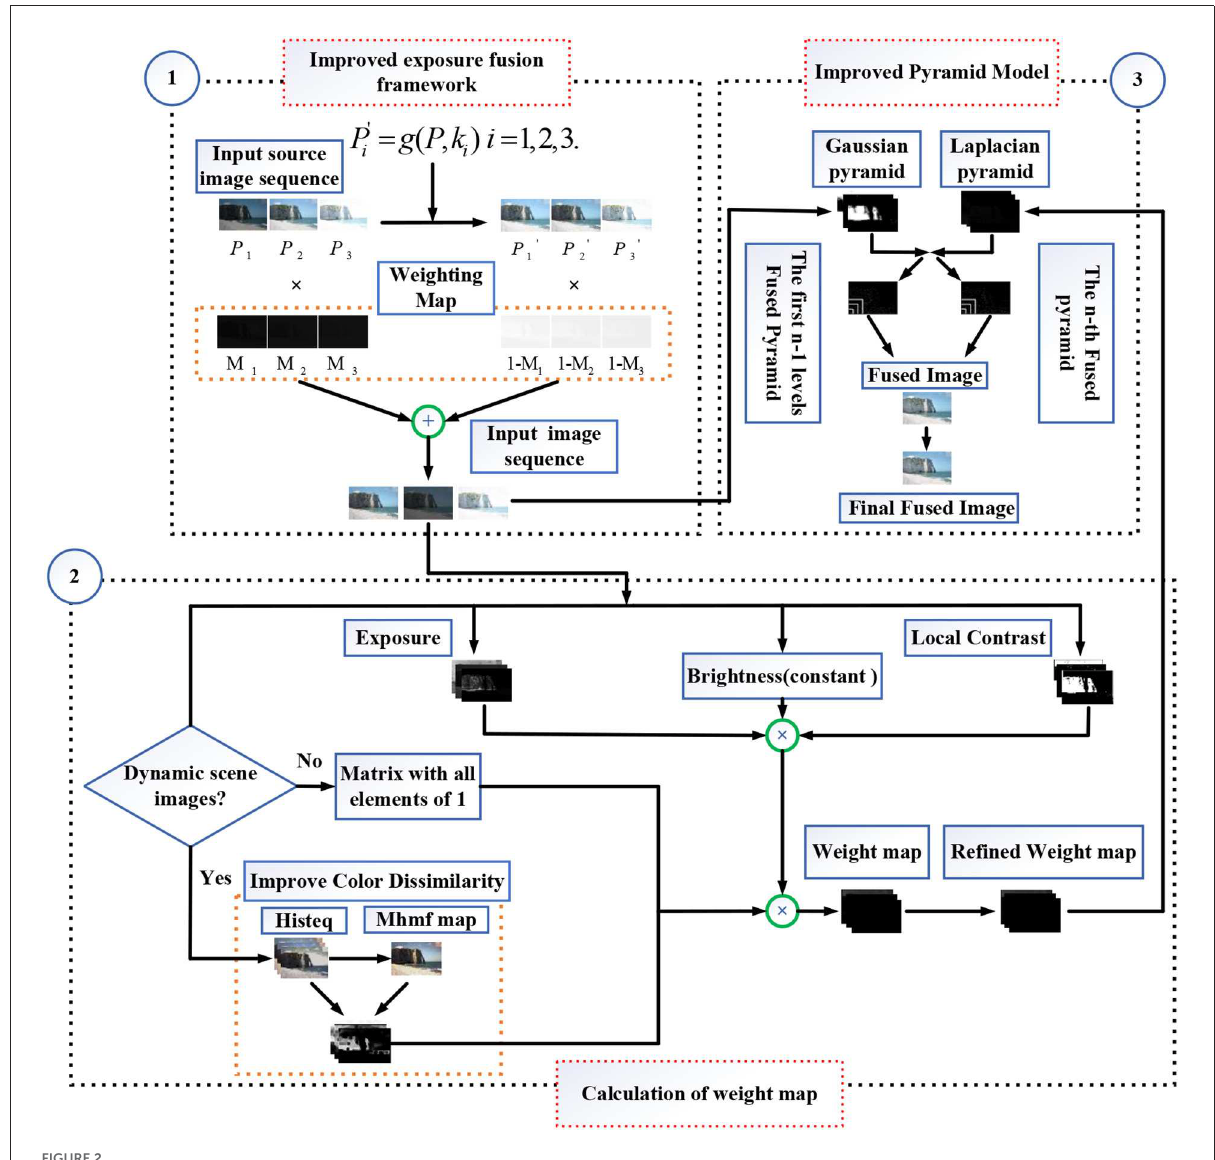
FIGURE2 Schematic diagram of the proposed